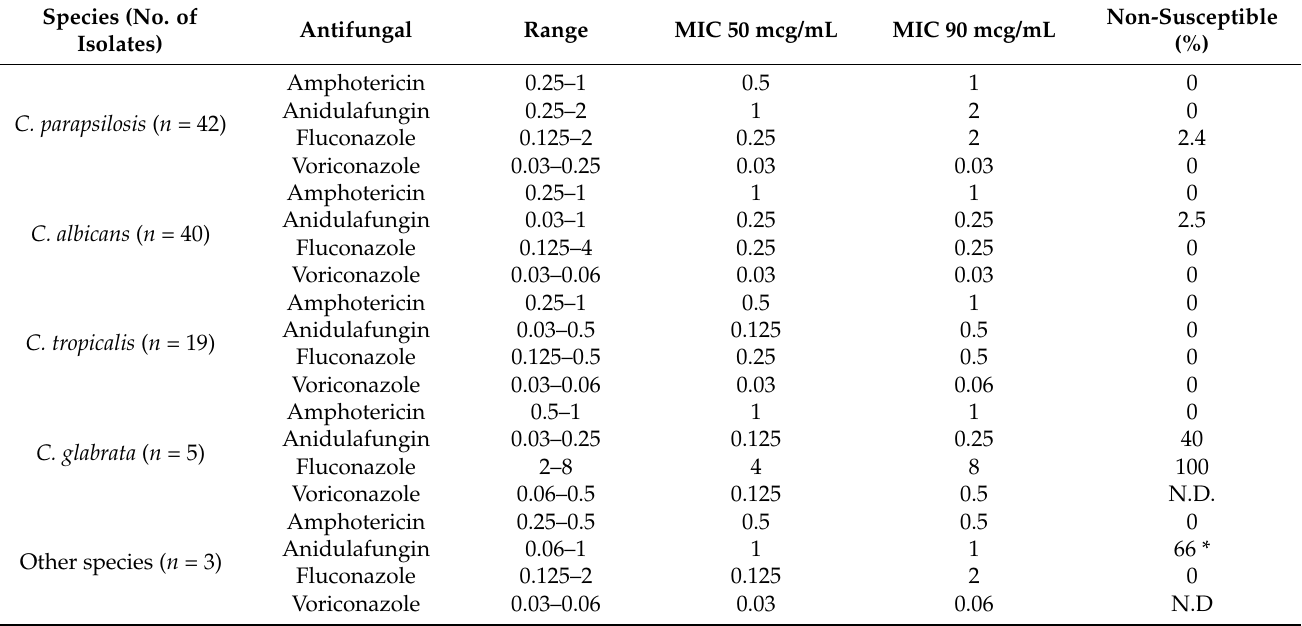
Table 2. Susceptibility results against selected